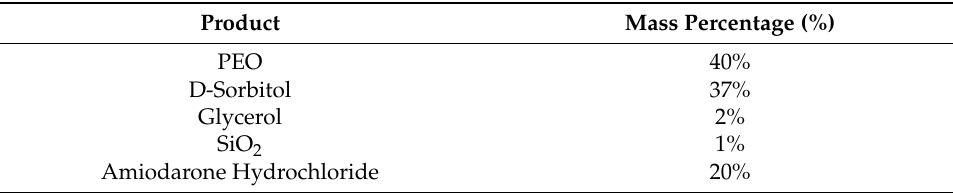
Table 1. Summary table of the percentage of each product in the